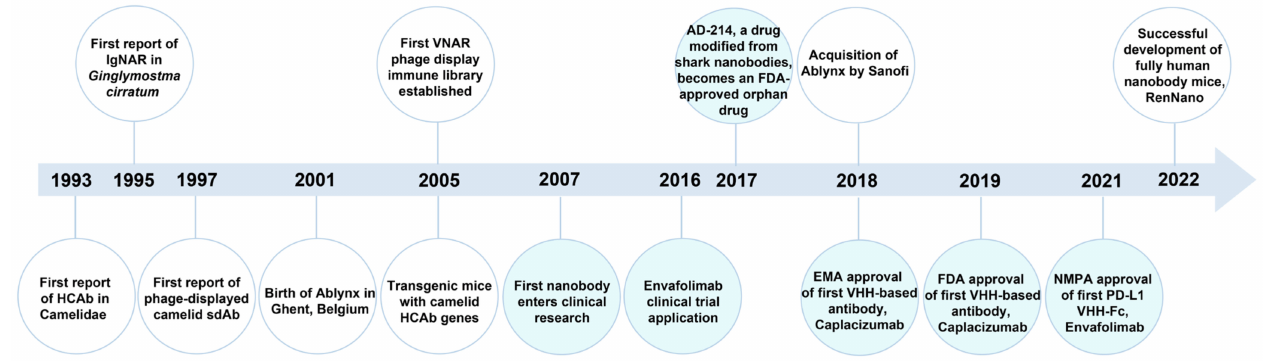
Figure 3. The development of nanobody. The light blue marker indicates the progress of research on nanobody drugs. FDA, Food and Drug Administration; EMA, European Medicines Agency; NMPA, National Medical Products Administration; HCAb, heavy-chain antibody; IgNAR, Ig new antigen receptors; sdAb, single domain antibody; VHH, variable domain of HCAb; VNAR, variable domain of IgNAR; PD-L1, programmed cell death 1 ligand